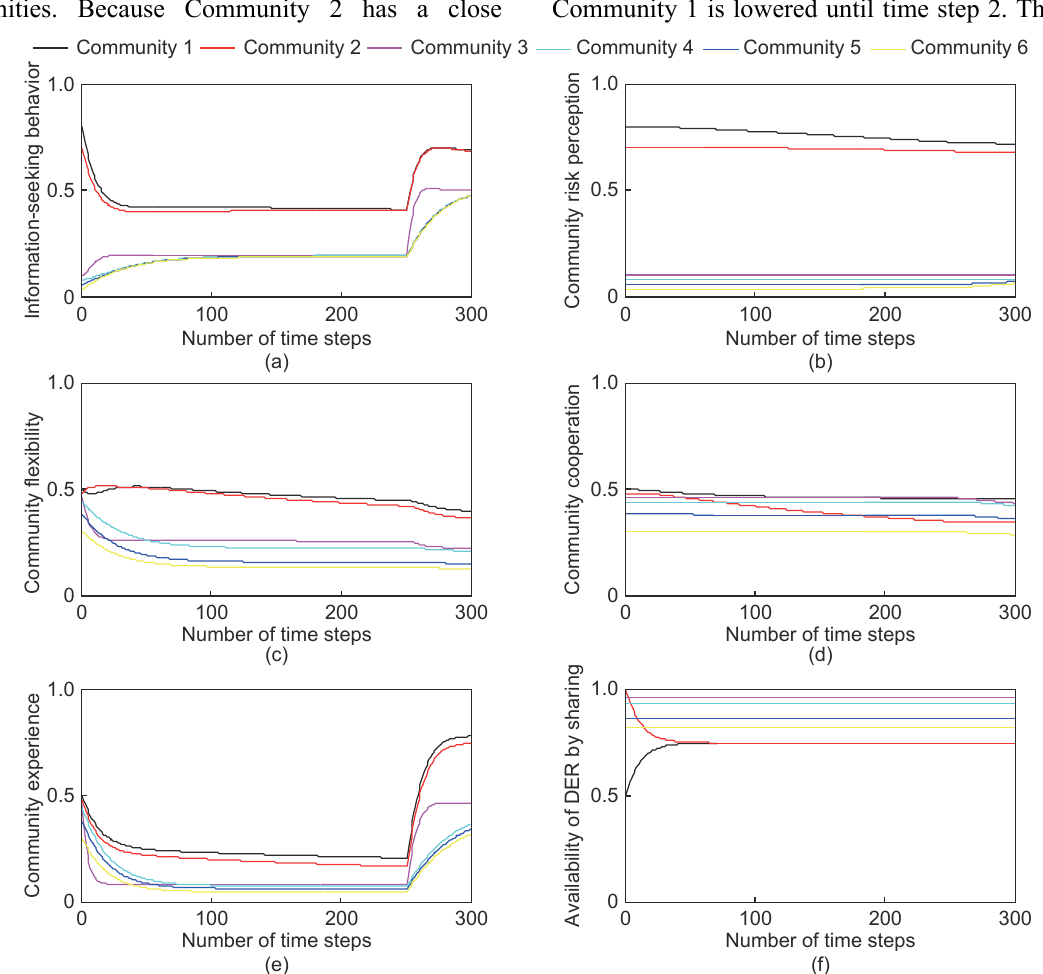
Fig. 9 Dynamic change of information-seeking behavior, risk perception, flexibility, cooperation, experience, and the availability of the electricity supplied by DERs for six communities. The disaster occurs in Community 1. Because Communities 2 and 1 are empathetic to each other, the disaster influences the mental characteristics of individuals in Community 2. In addition, other communities are not empathetic at